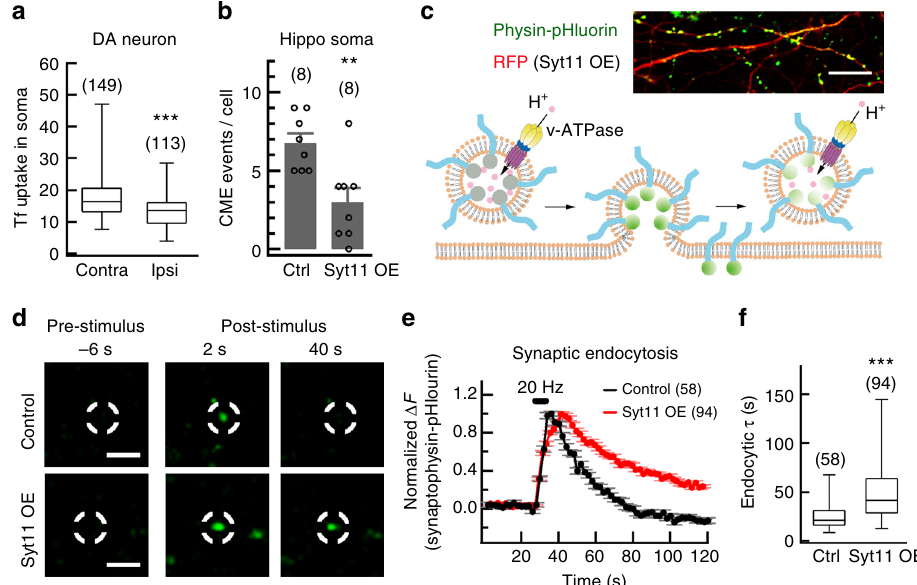
Fig. 4 Syt11 inhibits endocytosis in neurons. a Statistics showing the decreased transferrin (Tf) uptake of dopaminergic neurons in the SNpc by Syt11 overexpression (OE). Syt11-carrying lentivirus was unilaterally injected into the SNpc in TH-GFP mice and Tf uptake was assessed in the contralateral (Contra) and Syt11-overexpressing (Ipsi, ipsilateral) sides of the SNpc 1 month later ( P < 0.001, n represents number of neurons). b TIRF imaging of Clathrin-DsRed showing the inhibitory role of Syt11 in clathrin-mediated endocytosis (CME) in the somata of hippocampal neurons (Hippo soma, data are shown as mean ± s.e.m., P = 0.010, n represents number of imaged neurons). c Representative micrograph and cartoon showing the real-time imaging of synaptophysin-pHluorin during exocytosis and endocytosis. Upper panel, confocal image showing the expression of physin-pHluorin in hippocampal neurons. Lower panel, cartoon showing the fl uorescence change of physin-pHluorin during exocytosis and endocytosis. d Sample images showing phsin- pHluorin fl uorescence in presynaptic boutons of control (RFP-only) or Syt11 overexpressing (OE) hippocampal neurons before, 2 s after and 40 s after 100 stimuli at 20 Hz. e , f Normalized fl uorescence changes and statistics of endocytic tau ( τ ) of synaptophysin-pHluorin in Syt11 overexpressing or control hippocampal synapses ( P < 0.001, n represents the number of imaged synaptic boutons). Scale bars, 20 μ m for c and 5 μ m for d . Unpaired Student ’ s t -test for b , Mann – Whitney test for a , f , d , box and whisker plots show medians (central line in the box), ranges between 25th and 75th percentiles (box) and minimum – maximum ranges (whiskers). ** P < 0.01, *** P <